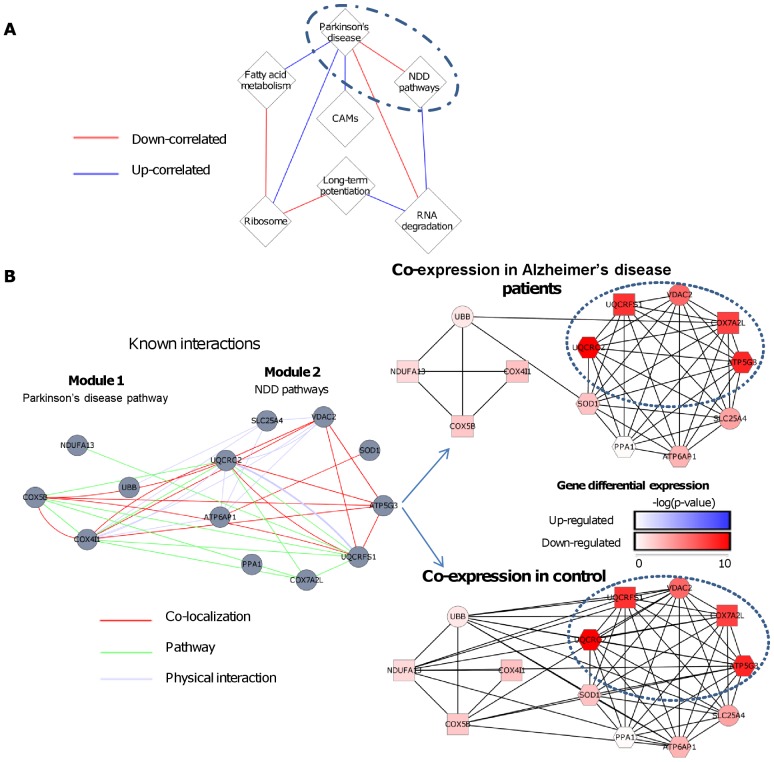
DC map of modules enriched with KEGG pathways discovered in the Alzheimer's disease data.(A) DC map of modules enriched with KEGG pathways. Nodes represent gene modules and edges correspond to DC (blue for increased correlation in AD, red for decreased correlation). Node size is proportional to the size of the module. The enriched pathways are noted on the module. NDD pathways refer to Parkinson's disease (PD), Huntington's disease, Alzheimer's disease and oxidative phosphorylation. CAMs refer to the cell adhesion molecules pathway. (B) Analysis of DC between the PD and the NDD modules (the circled sub-graph in A). Left: the known interactions involving the genes of the two modules according to GENEMANIA. Most known interactions are between the modules. Right: co-expression networks of the same genes for AD patients and controls. Rectangular nodes are genes related to oxidoreductase activity, hexagons indicate genes related to phosphate metabolic process. An edge between two genes indicates correlation >0.3 in the tested class. The average correlation between the modules was 0.3 in the controls and 0 in the AD class. Node colors indicate the DE between case and control, measured by the base-10 logarithm of the p-value (t-test) of the tested gene. The genes circled in the NDD pathway module are also part of the PD pathway. These genes are also down-correlated in AD, whereas all other genes show only mild DE.